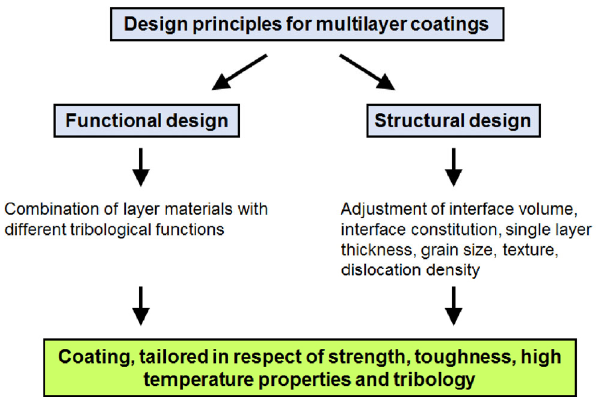
Fig. 2 Design principles of multilayer coatings. Adopted from Ref. [6], with permission from